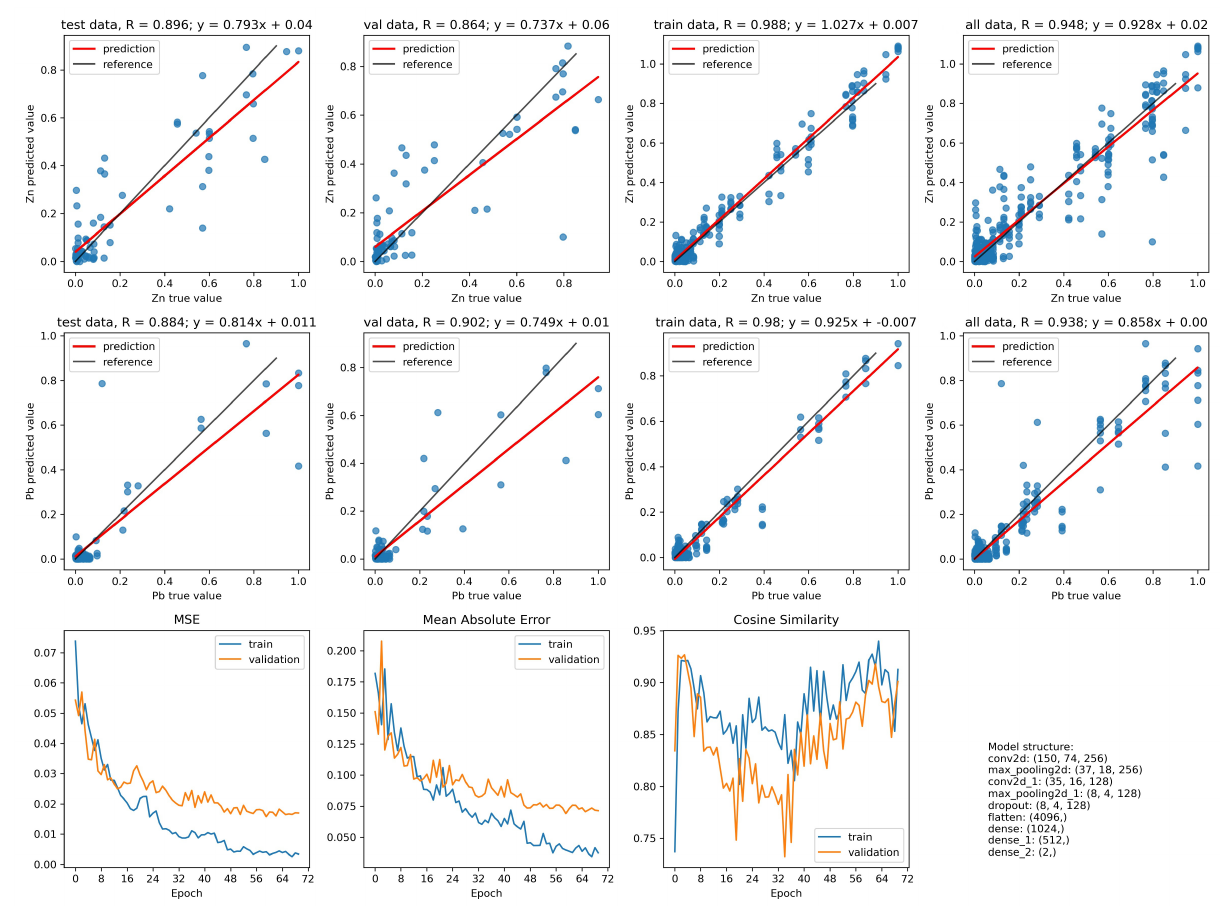
Figure 6. Best results obtained by the network structure with index 2. The top two rows represent the scatter plots with true values of metal concentrations on the x-axis and predicted values of metal concentrations on the y-axis. The first row corresponds to zinc, while the second row corresponds to lead. Results for test validation, training and full dataset are presented in the first, second, third and fourth columns, respectively (counting from the left). Finally, in the bottom row, the values of mean absolute error, mean squared error, cosine similarity and general model structure are